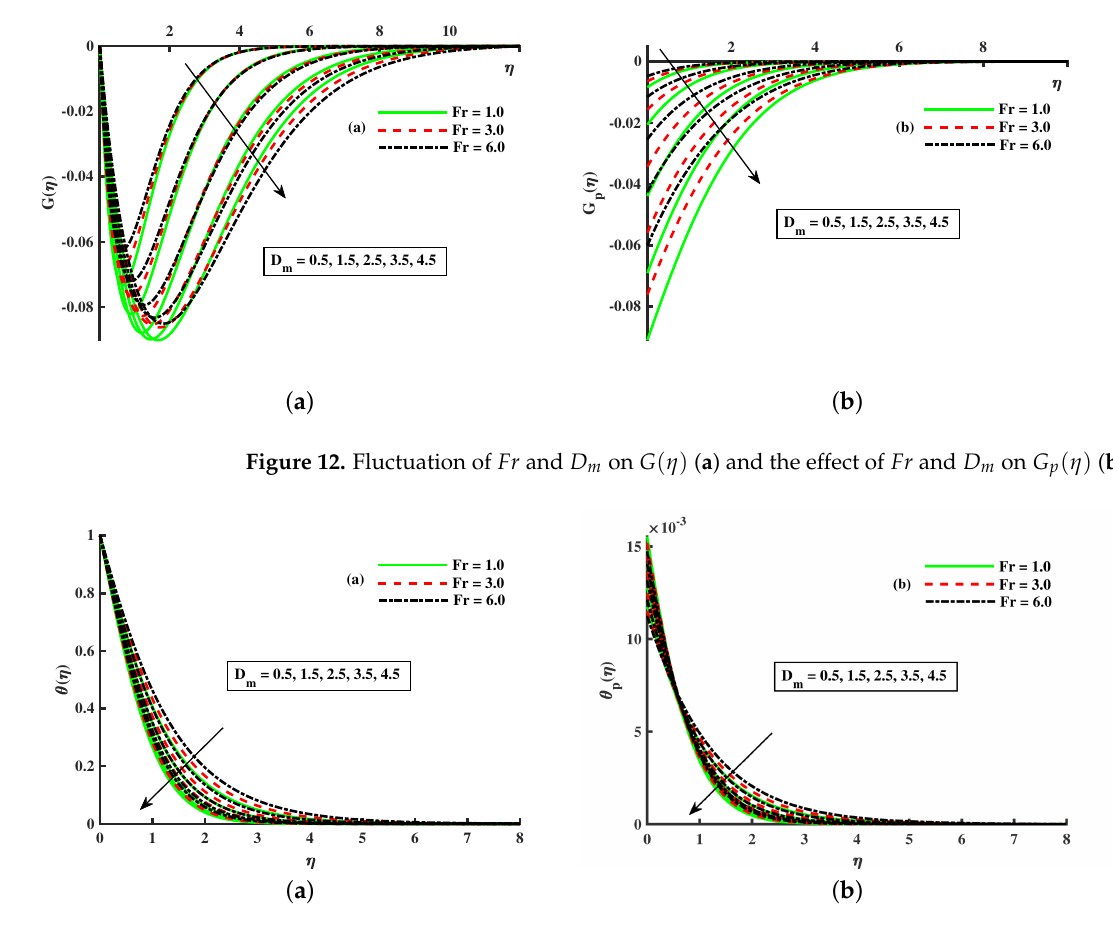
Figure 13. Fluctuation of Fr and D m on θ ( η ) ( a ) and the effect of Fr and D m on θ p ( η ) ( b ).